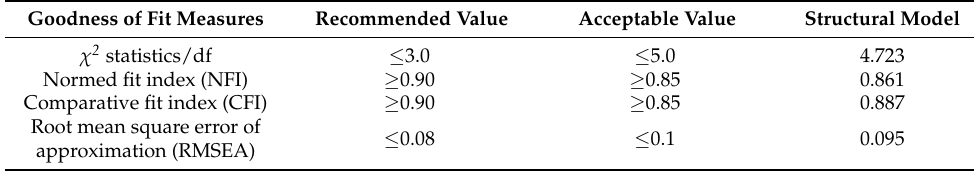
Table 9. Goodness of fit- structural